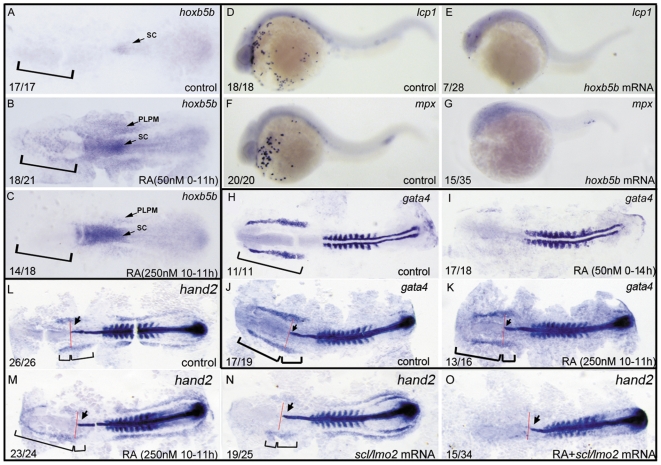
ALPM is lost in the embryos treated with 50 nM RA from 1–2-cell stage to 11 hpf but not eliminated in the ones treated with 250 nM RA during 10–11 hpf.All embryos including flat-mounted embryos (A–C, H–O) and whole-mounted embryos (D–G) are positioned anterior left and dorsal front (A–C, H–O) or lateral front (D–G). Embryos treated with vehicle DMSO (A), 50 nM RA from 1–2-cell stage to 11 hpf (B), and 250 nM RA during 10–11 hpf (C) were examined for hoxb5b expression at 11 hpf (A–C). Embryos treated with 50 nM RA treatment from 1–2-cell stage to 11 hpf displayed ectopically expression of hoxb5b in ALPM (B) but the ones treated with 250 nM RA during 10–11 hpf did not exhibit this ectopical expression (C). Compared with control embryos (D, F), overexpressions of hoxb5b by microinjecting embryos at 1–2-cell stage with hoxb5b mRNA significantly suppressed expressions of lcp1 (E) and mpx (G) at 24 hpf. Embryos treated with vehicle DMSO (H, J), 50 nM RA from 1–2-cell stage to 14 hpf (I) or 250 nM RA during 10–11 hpf (K) were examined for expressions of ALPM marker gata4 at 14 hpf. The location of ALPM at 11 hpf (A–C) or at 14 hpf (H, J, K) is indicated by bracket. Embryos treated with vehicle DMSO (L), 250 nM RA during 10–11 hpf (M, O), or microinjected with scl/lmo2 mRNA (N, O) were examined for expressions of cardiac marker hand2 at 14 hpf. Expression of myoD in somites (H–O) was used for staging and ntl expression was used for labeling embryonic axial mesoderm (J–O). The length between the anterior end of gata4 expression domain (J, K) or hand 2 expression domain (L–N) and the anterior end of ntl expression domain and the length between the posterior end of gata4 expression domain (J, K) or hand 2 expression domain (L–N) and the anterior end of ntl expression domain are marked by two different brackets. Red line denotes the anterior level of ntl expression domain (J–O). Arrow indicates the most anterior end of notochord marked by expression of ntl (J–O). sc: spinal cord; PLPM: posterior lateral plate mesoderm. The number shown in the lower left-hand corner of each panel is the number of embryos exhibiting the typical phenotype shown in the panel to the number of embryos totally observed.